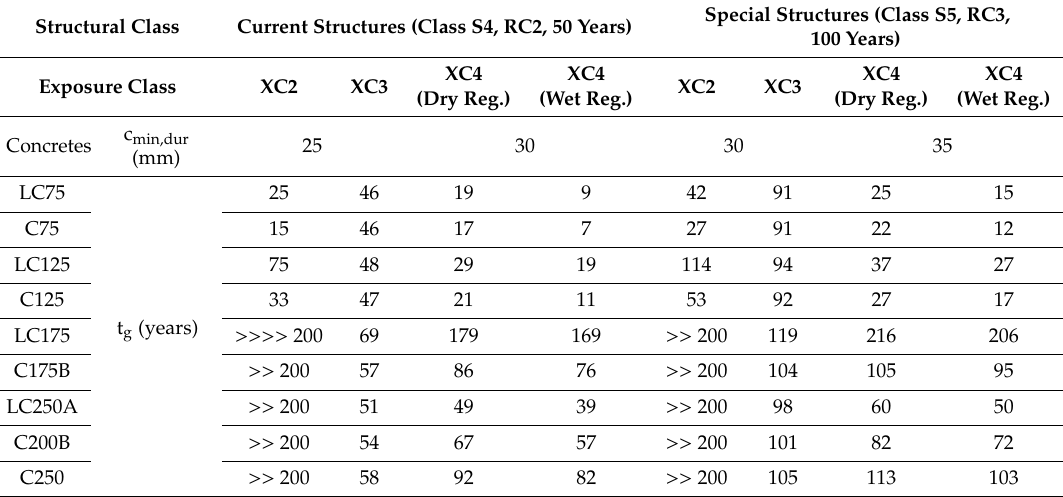
Table 8. Service lifetime (years) for current and special structures produced with the studied concrete under environmental conditions